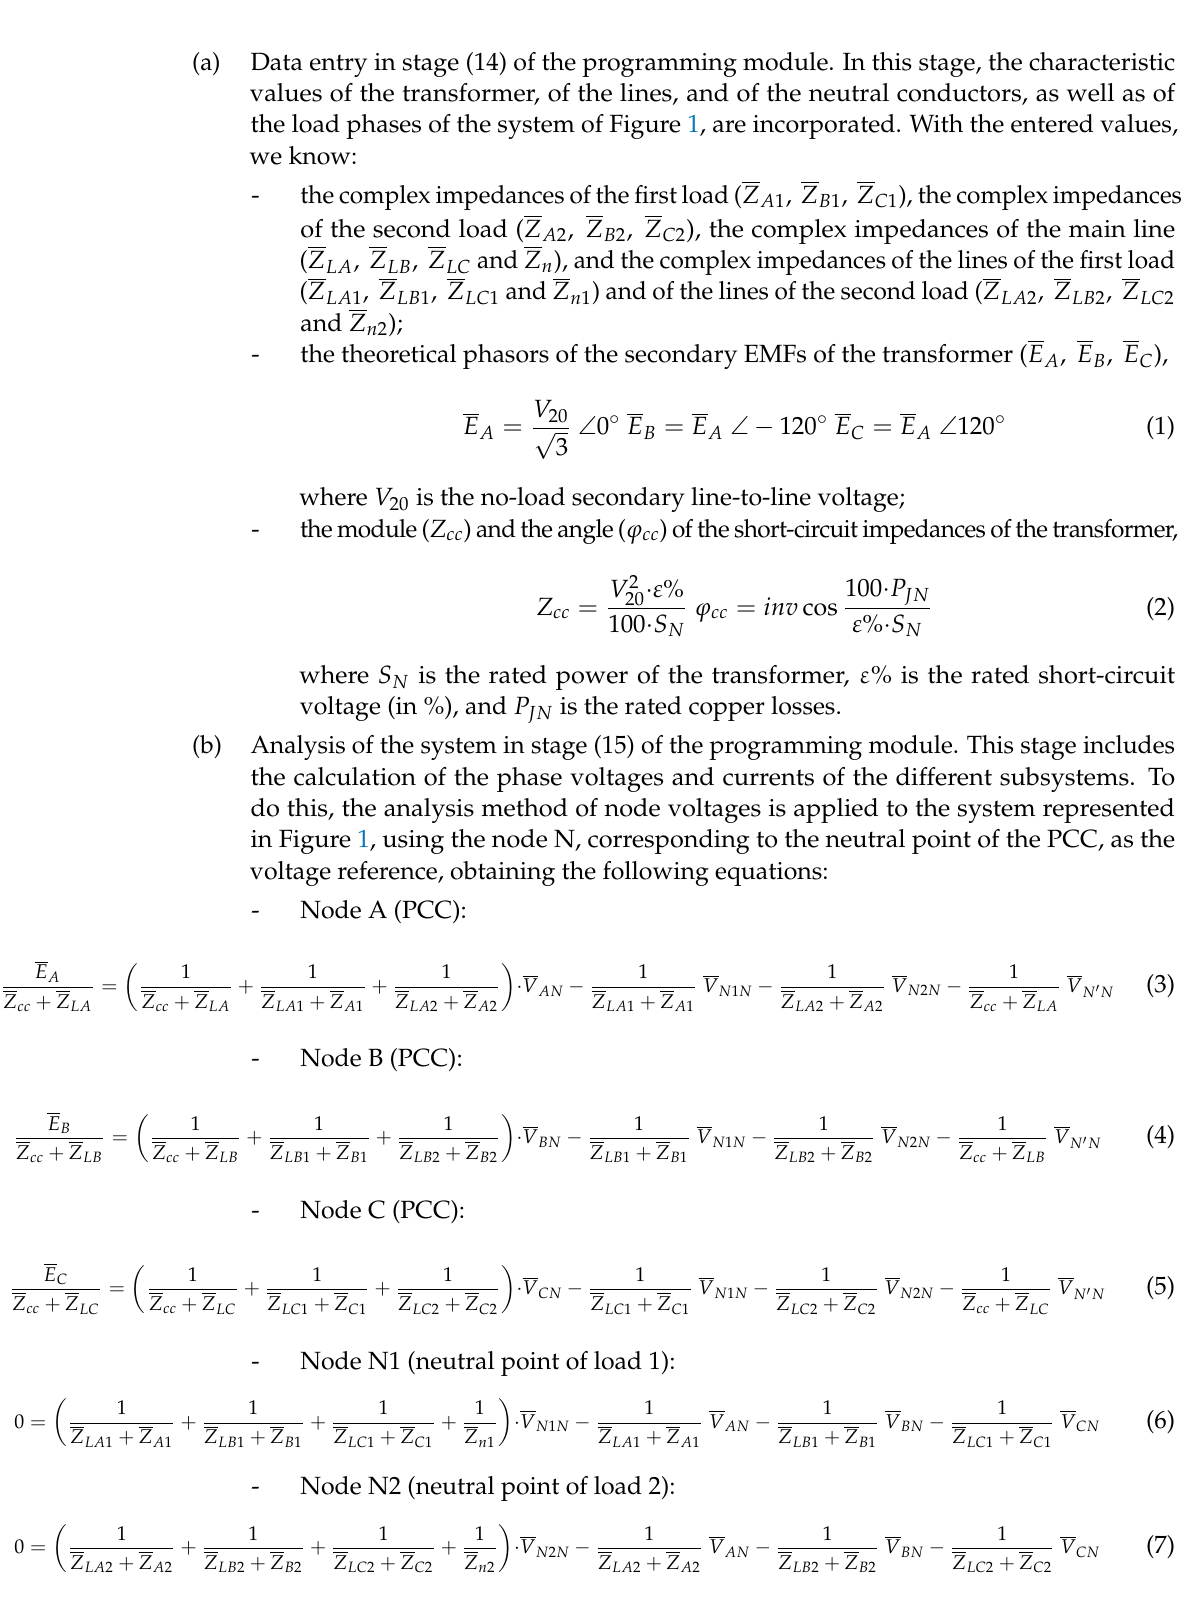
Node N’ (neutral point of the